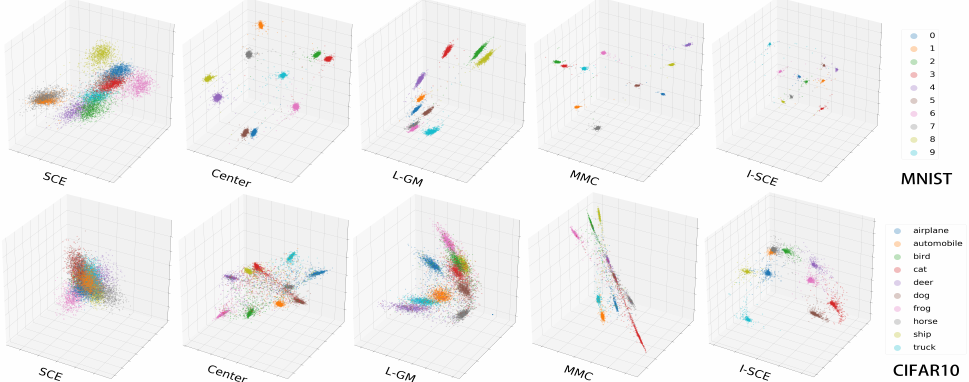
Figure 9. Illustration of three-dimensional feature